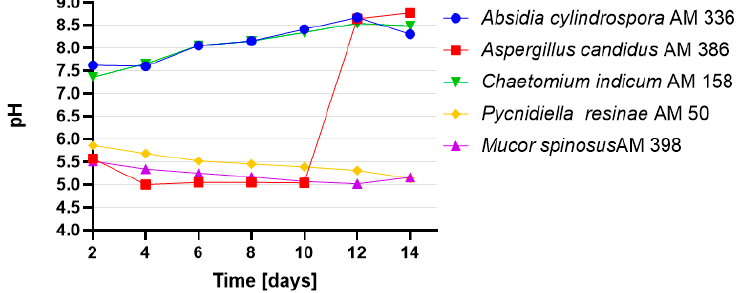
Figure 3. pH values of cultures during the screening-scale transformations of 3- n -butylidenephthalide ( 1 ).